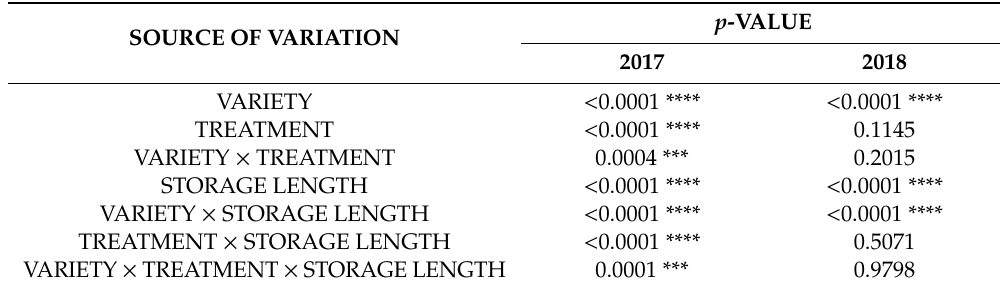
Table 2. ANOVA table for glucose content of chipping varieties.